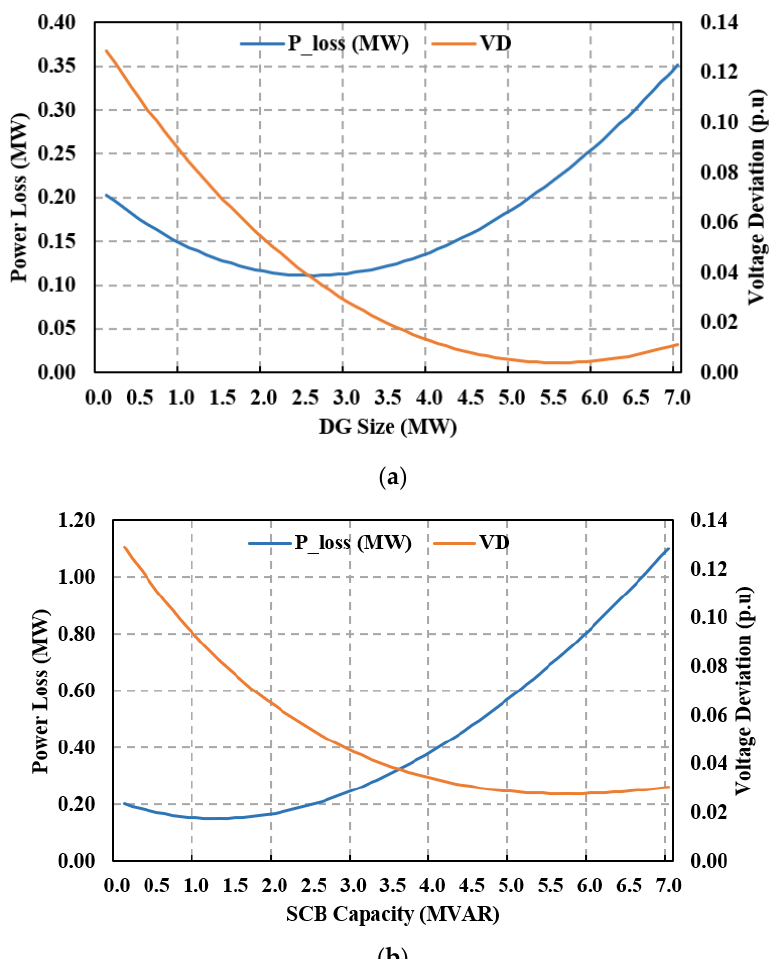
Figure 2. Impact of DG/SCB size on the power loss and voltage deviation in the distribution net ‐ work; ( a ) for DG, ( b ) for SCB.